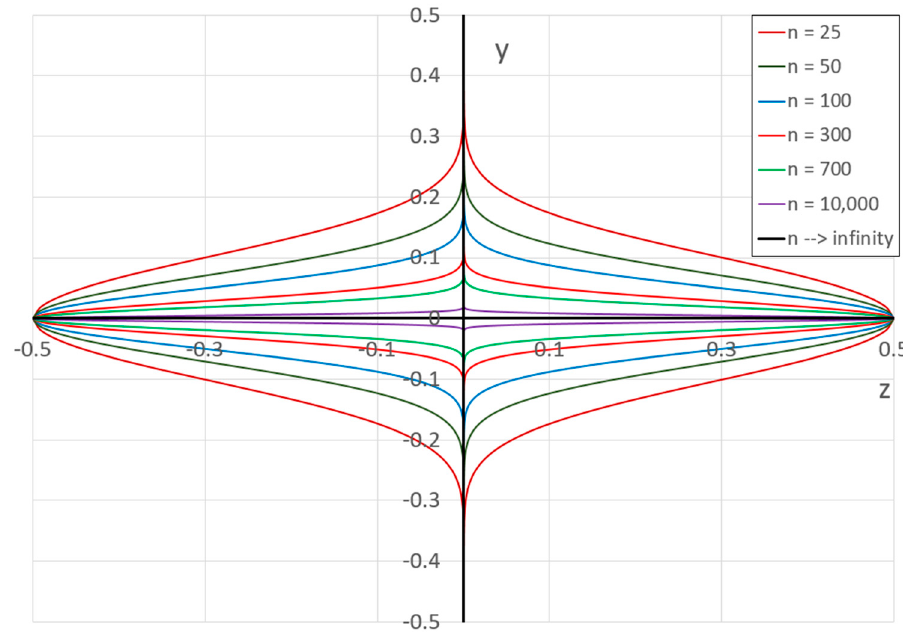
Figure 8. E ff ect of n on the shape of a cross-section. Figure 8. Effect of 𝑛 on the shape of a cross-section.